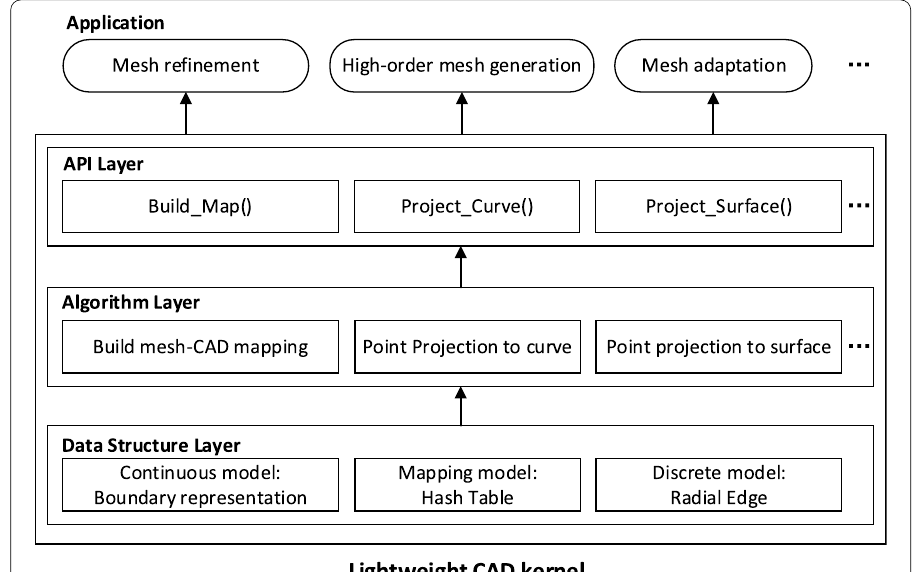
Fig. 1 Layered structure of the